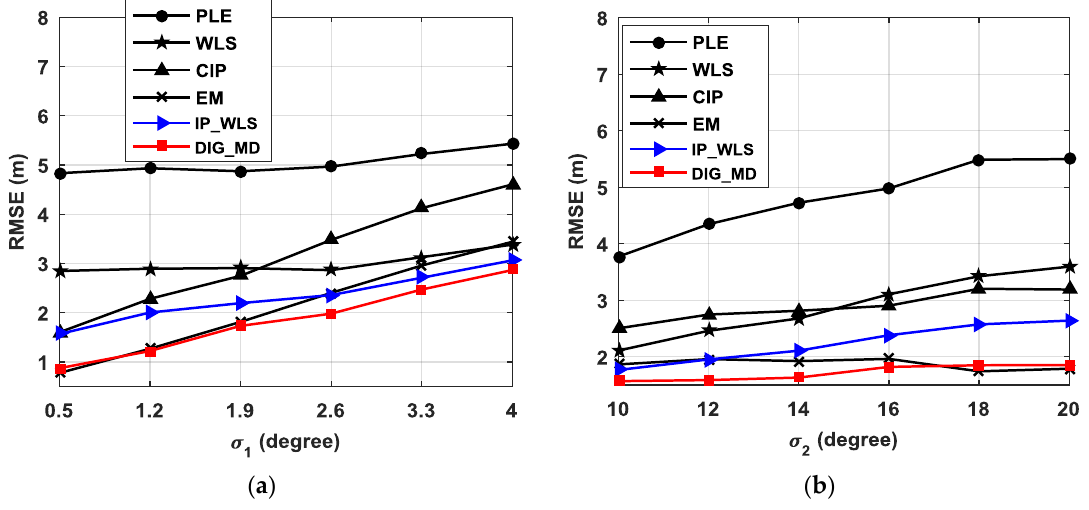
Figure 4. The RMSEs of the pseudolinear estimator (PLE), weighted least squares (WLS), center of all intersected points (CIP), expectation maximization (EM), IP_WLS, and division and greedy replacement–Mahalanobis distance (DIG_MD) methods with ( a ) different σ 1 when σ 2 = 15 ◦ , ( b ) different σ 2 when σ 1 = 2 ◦ . ( u = 6, m = 4